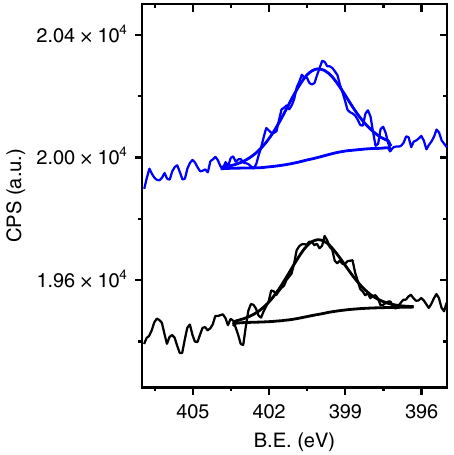
Fig. 8 N1 s XPS signals of EC-deposited dimethyl-benzimidazole on Au fi lm. EC deposition was conducted with 5 and 25 mM dimethyl- benzimidazolium iodide (black- and blue-colored spectra,